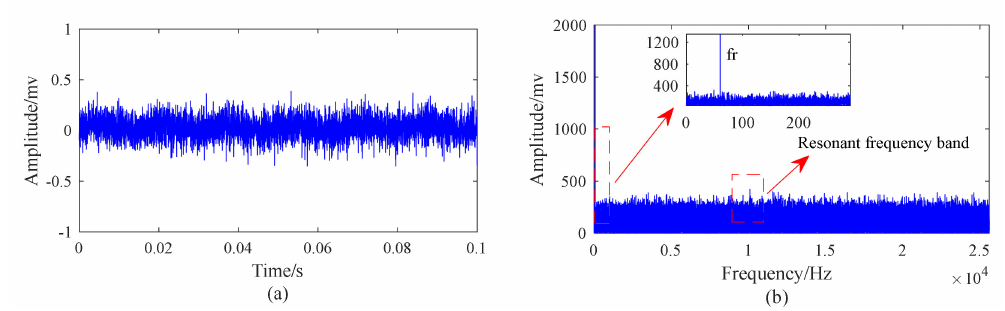
Figure 14. The simulation signal of the bearing with the inner race fault: ( a ) waveform; ( b )